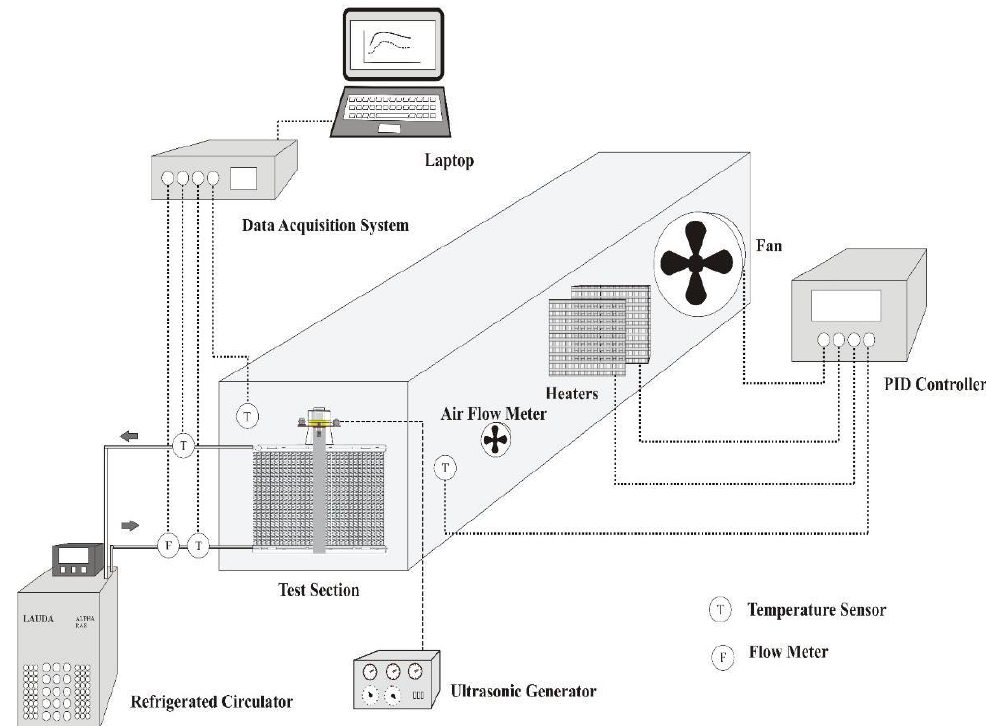
Figure 1. The schematic of the experimental setup.